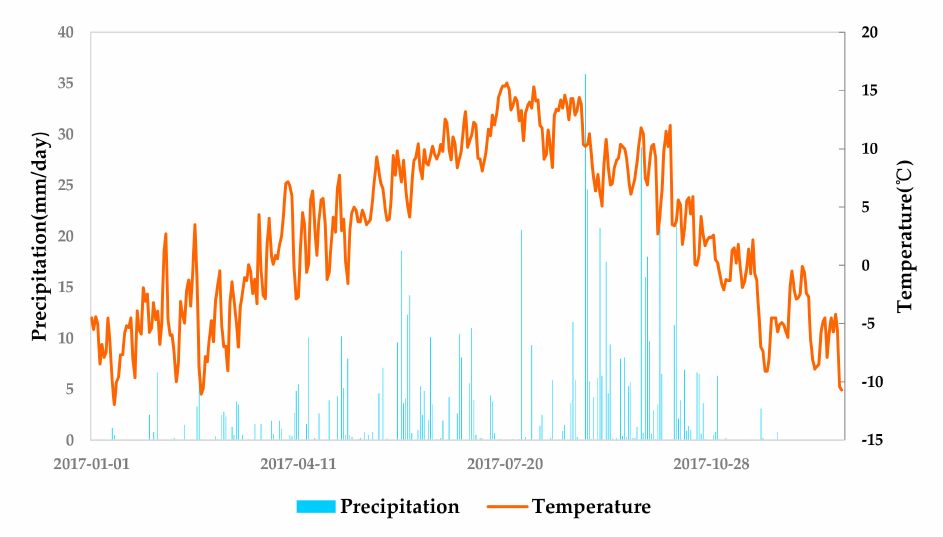
Figure 2. Dynamics of daily precipitation and temperature of Zoige in